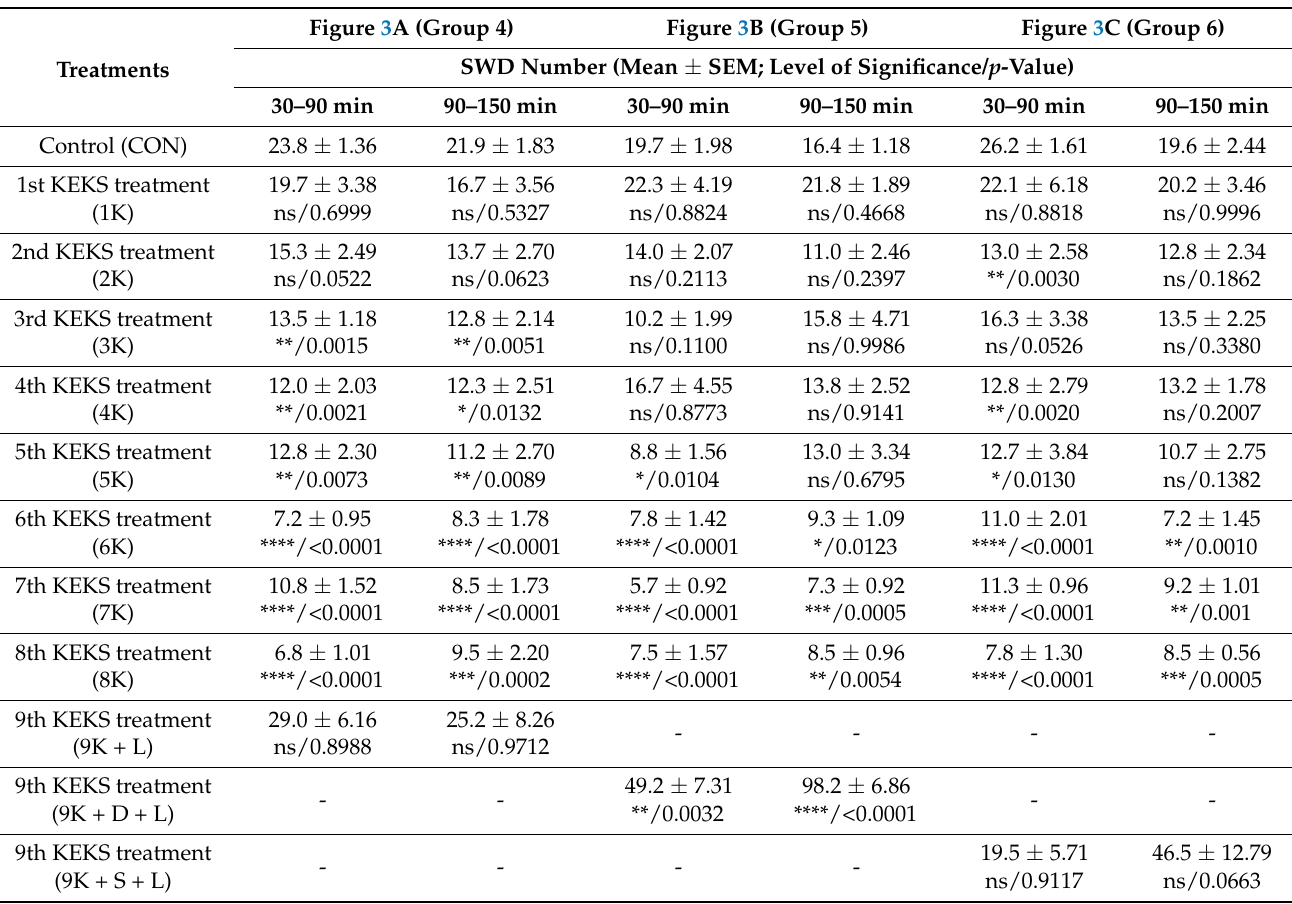
Table 2. Influence of KEKS-supplemented food (paste-like standard rodent chow containing 10% ketone ester/KE, 10% ketone salt/KS and 1% saccharin) on SWD number between first (1K) and 8th (8K) day of administration and on 9th day of KEKS food (9K) administration combined with i.p. LPS (L) (9K + L), i.p. DPCPX (D) and LPS (9K + D + L), as well as i.p. SCH58261 (S) and LPS (9K + S + L), compared to control (CON).